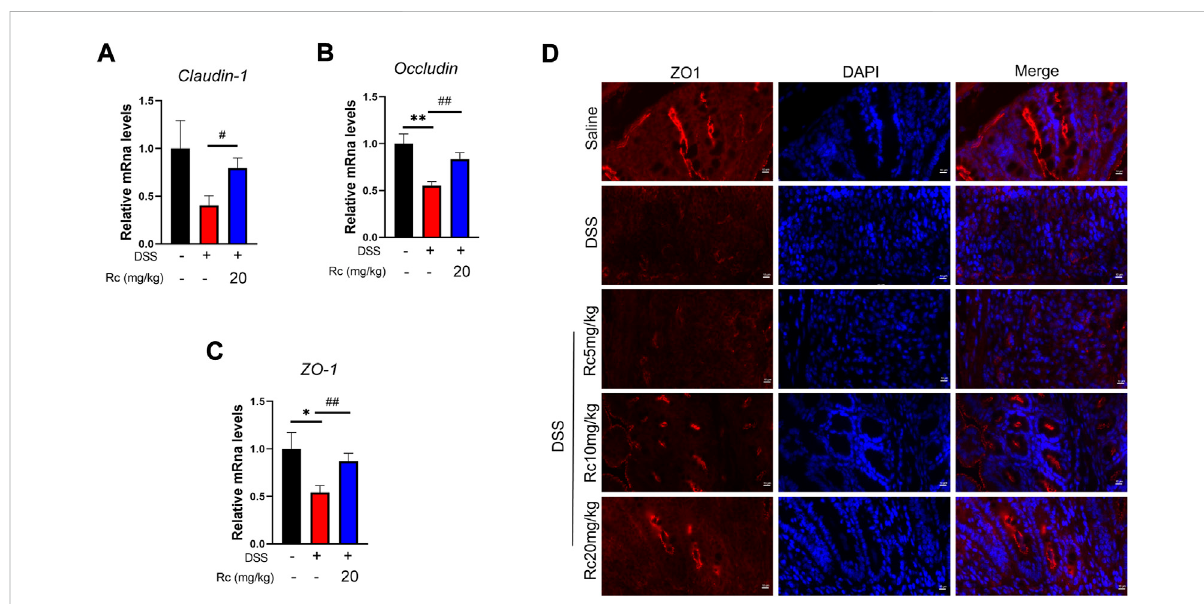
FIGURE 4 RcmaintainspropertightjunctionsinDSS-inducedmice.ThecolonswerecollectedforqPCRanalysis,andtherelativemRNAlevelsof claudin- 1 (A) , occludin (B) ,and ZO-1 (C) weremeasured;representativeimagesofimmuno fl uorescenceofZO-1 (D) inmousecolonsections(magni fi cation: 200 ×). Data are shown as the mean ± SEM ( n = 6). * p < 0.05, ** p < 0.01 vs . the saline group; # p < 0.05, ## p < 0.01 vs . the DSS